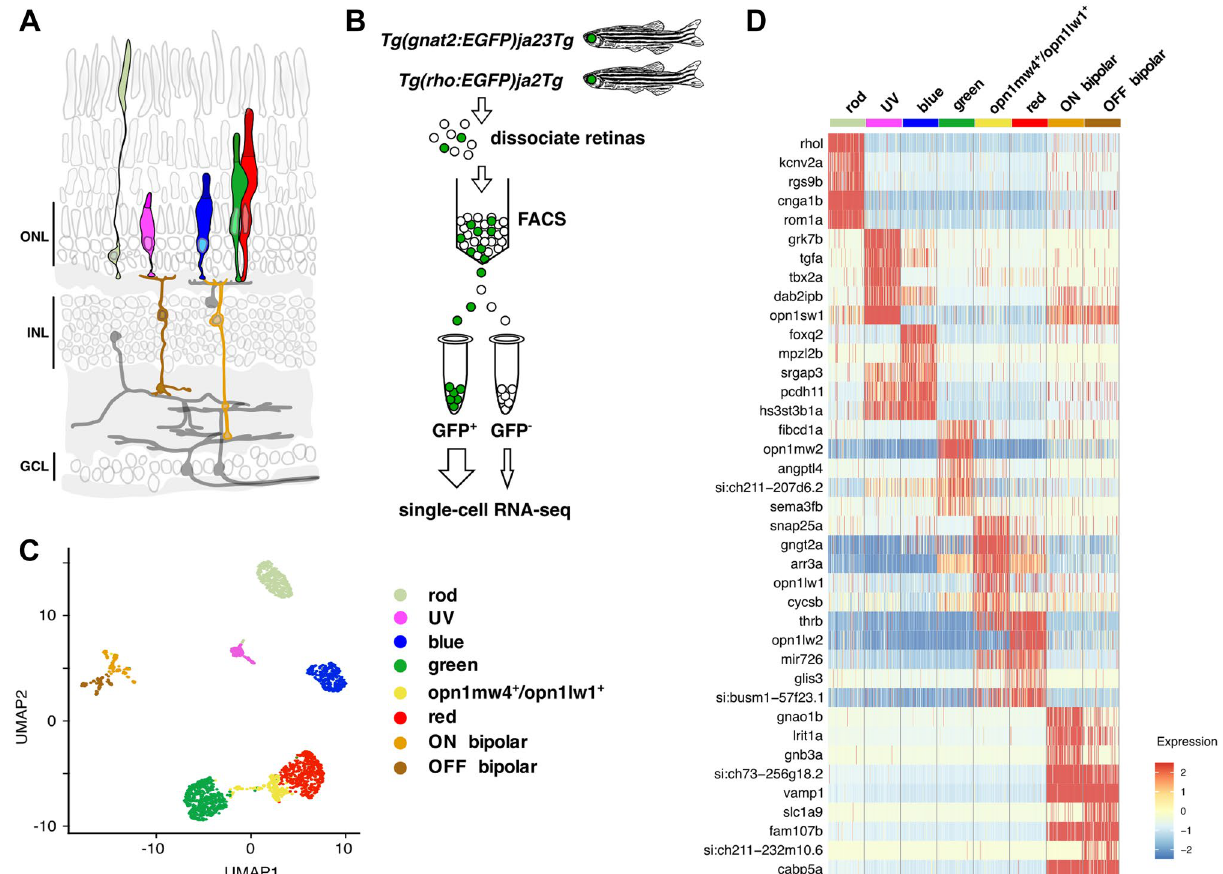
Figure 1. Transcriptome profiles of adult zebrafish photoreceptor subtypes. ( A ) Schematic representation of the major cell classes in the zebrafish retina based on a prior design 7 . Photoreceptor cell types and ON and OFF bipolar cells are highlighted in color, whereas other retinal cell types are in grey. The ON bipolar cell cluster in our single cell data expresses genes specific to both rod ON bipolar cells ( prkcaa ) and cone ON bipolar cells ( gnao1b, gnb3a, trpm1a, rgs11, and isl1 ). See also Fig. S1. ONL outer nuclear layer, INL inner nuclear layer, GCL ganglion cell layer. ( B ) Isolation of rod and cone cells from transgenic adult zebrafish expressing green fluorescent protein (GFP). GFP-positive cells were collected from each line. A small percentage of GFP-negative cells was also included in the analysis. ( C ) Automatic clustering of single-cell expression profiles reveals six distinct photoreceptor populations. The plot shows a two-dimensional representation (UMAP) of global gene expression relationships among 2186 cells. ( D ) Heatmap showing top five differentially enriched genes for each cell population (rows). Columns correspond to single cells grouped by cell cluster. Each cell cluster is colored as in panel ( C ). Values are row-wise Z-scored gene-expression values . See also Fig. S1A. Full list of differentially enriched genes is provided in Supplementary Data